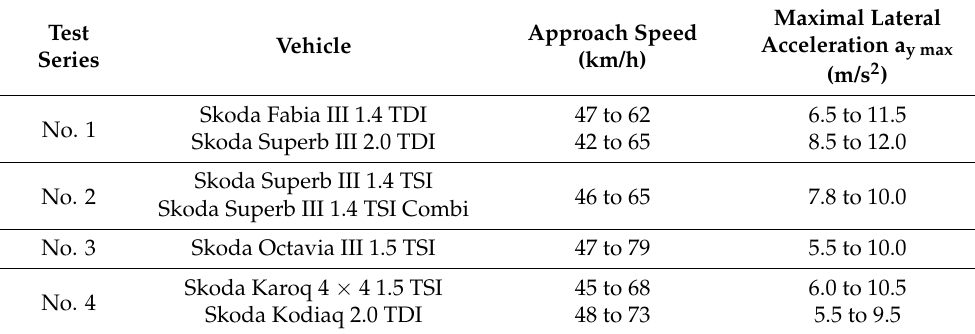
Table 7. Documented lateral acceleration in the individual test